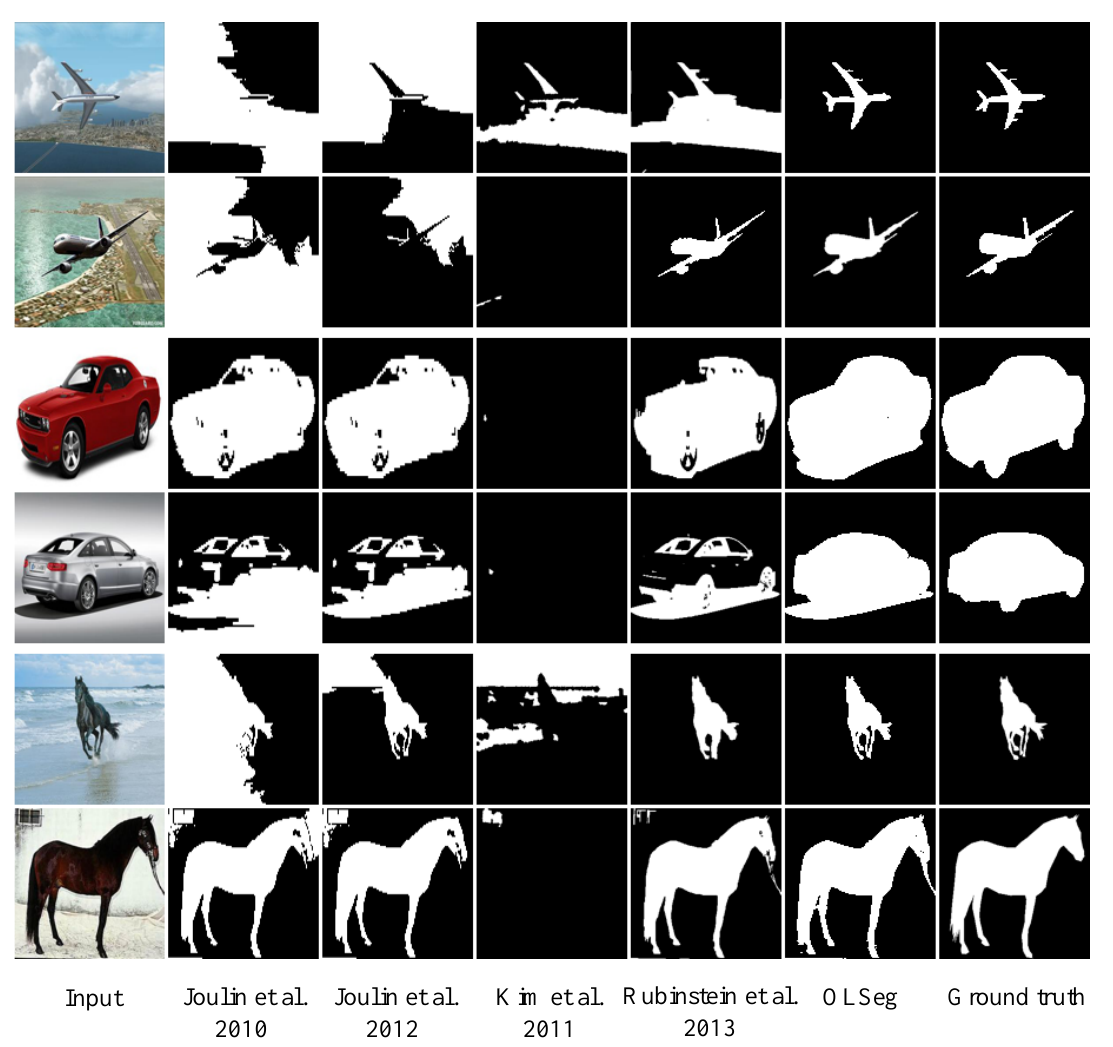
Figure 9. The qualitative results of different methods on the Internet dataset. OLSeg produces improved results compared to other methods in [12–15].